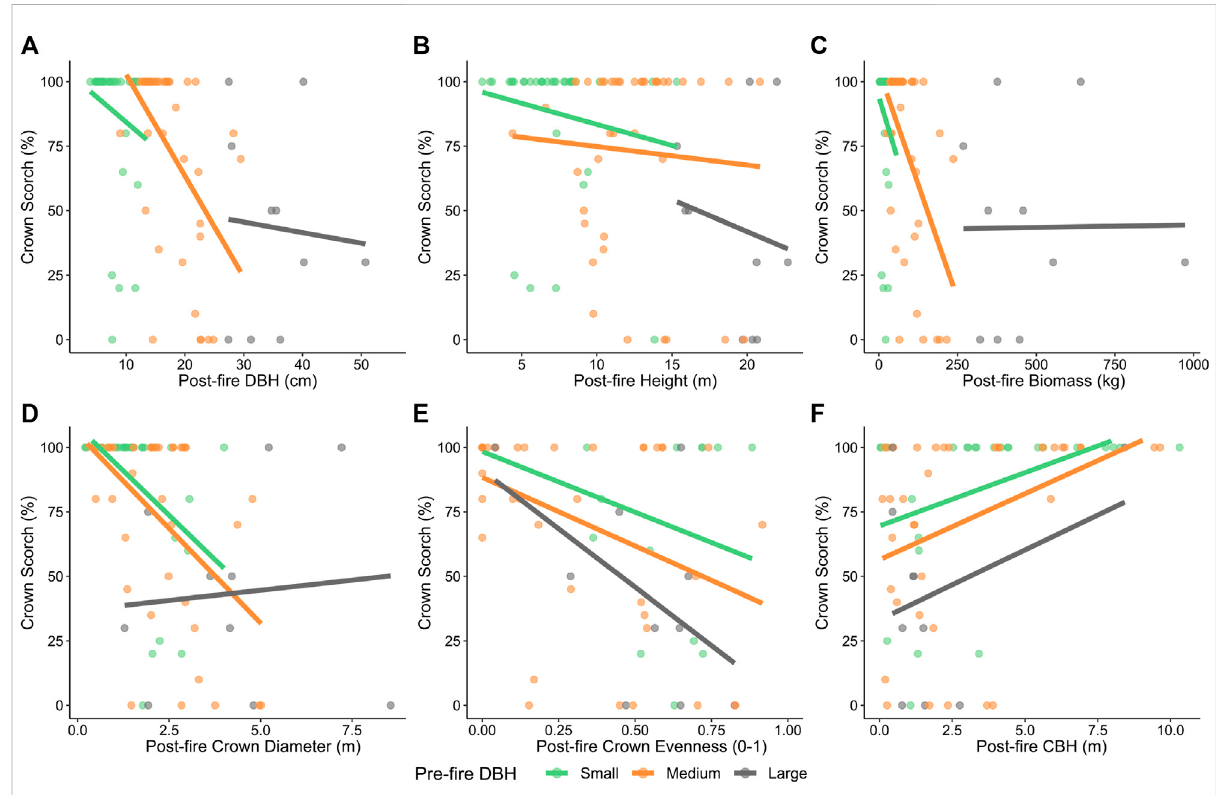
FIGURE 8 The scatter plots and trend lines between crown scorch (%) and post- fi re (A) DBH, (B) height, (C) biomass, (D) crown diameter, (E) crown evenness, and (F) CBH among small-, medium-, and large-diameter trees classi fi ed using pre- fi re DBH